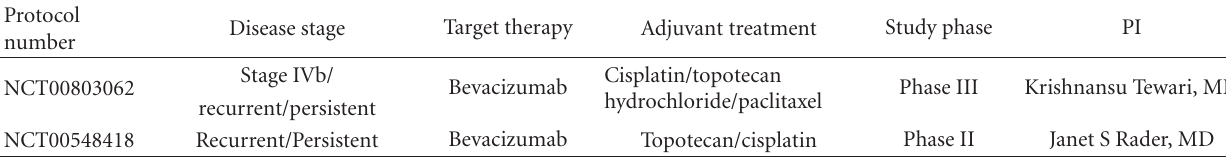
Table 3: Ongoing treatment studies evaluating EGFR MoAbs in cervical cancer patients.